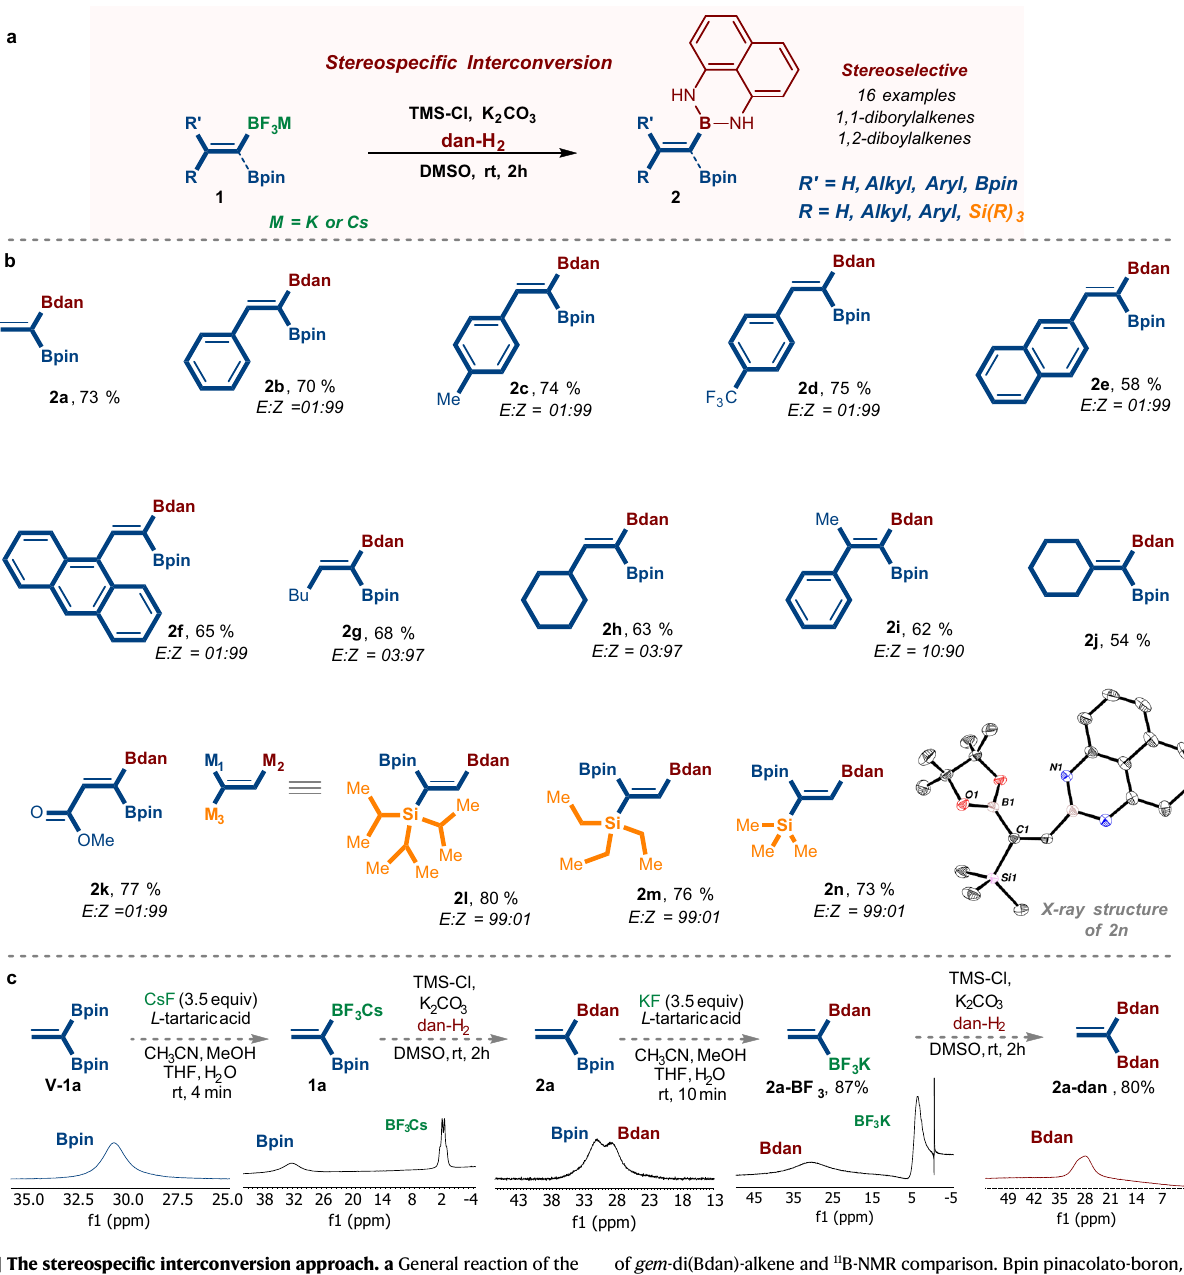
Fig. 3 | The stereospeci fi c interconversion approach. a General reaction of the stereospeci fi c interconversion of the tri fl ouroborates into the dan containing alkenes. b The scope of the reaction. c A sequential B-masking for the preparation